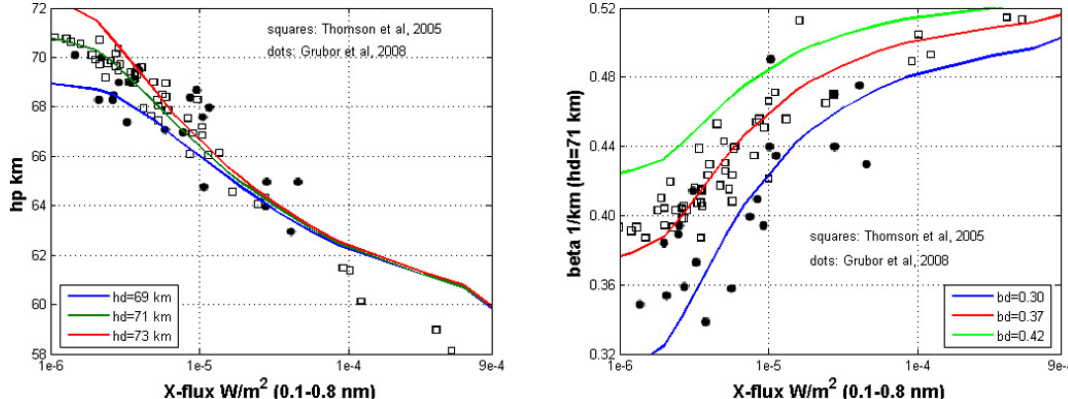
Fig. 4. Electron density profile height h 0 and steepness β vs. flare X-flux (0.1–0.8nm) at sun zenith angle z = 0.